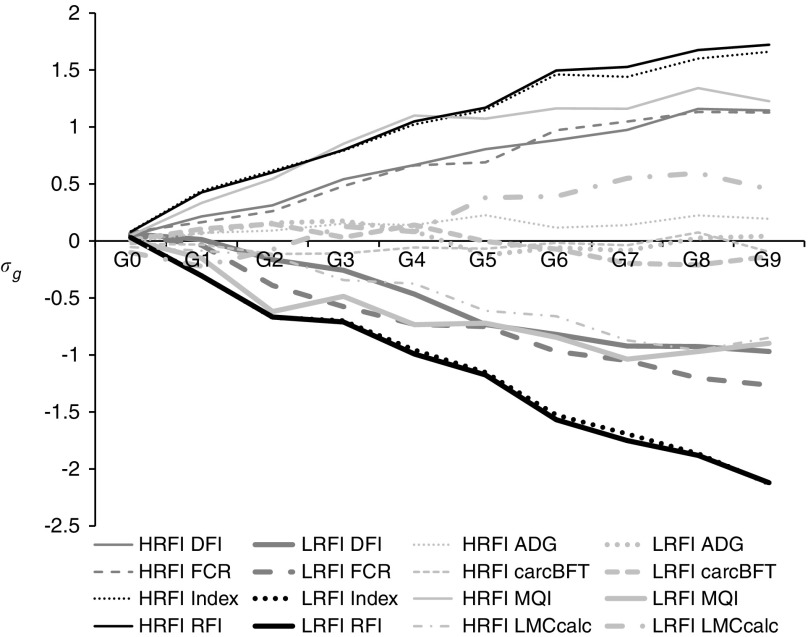
Genetic trends in the divergent selection experiment for residual feed intake (RFI)
on component traits and meat quality expressed in genetic standard deviations of the
traits (σ
g), obtained from a linear mixed model including an animal random effect
structured by the pedigree relationship matrix. HRFI=high RFI line; LRFI=low RFI
line; Index=selection index; DFI=daily feed intake; ADG=average daily gain; FCR=feed
conversion ratio; carcBFT=backfat thickness measured on the carcass; MQI=meat
quality index; LMCcalc=lean meat content of the carcass computed from a linear
combination of cut weights.